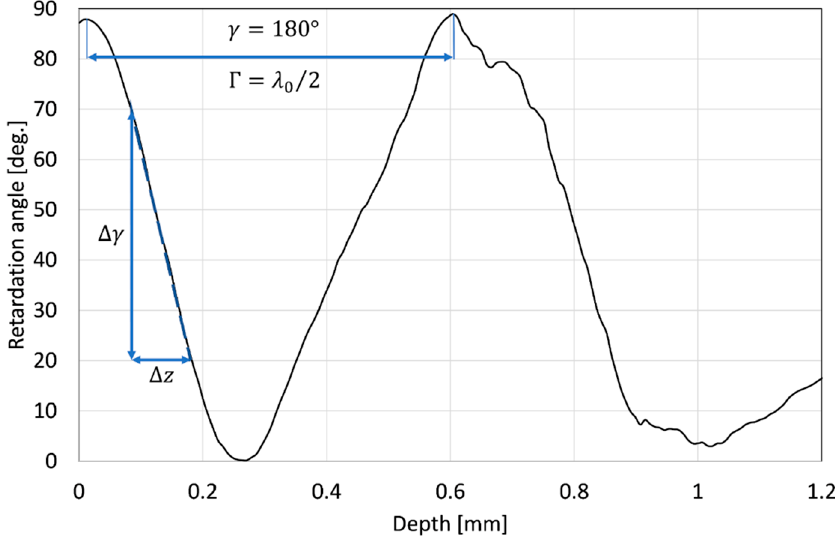
Figure 8. An example of a plot of the retardation angle taken for a single